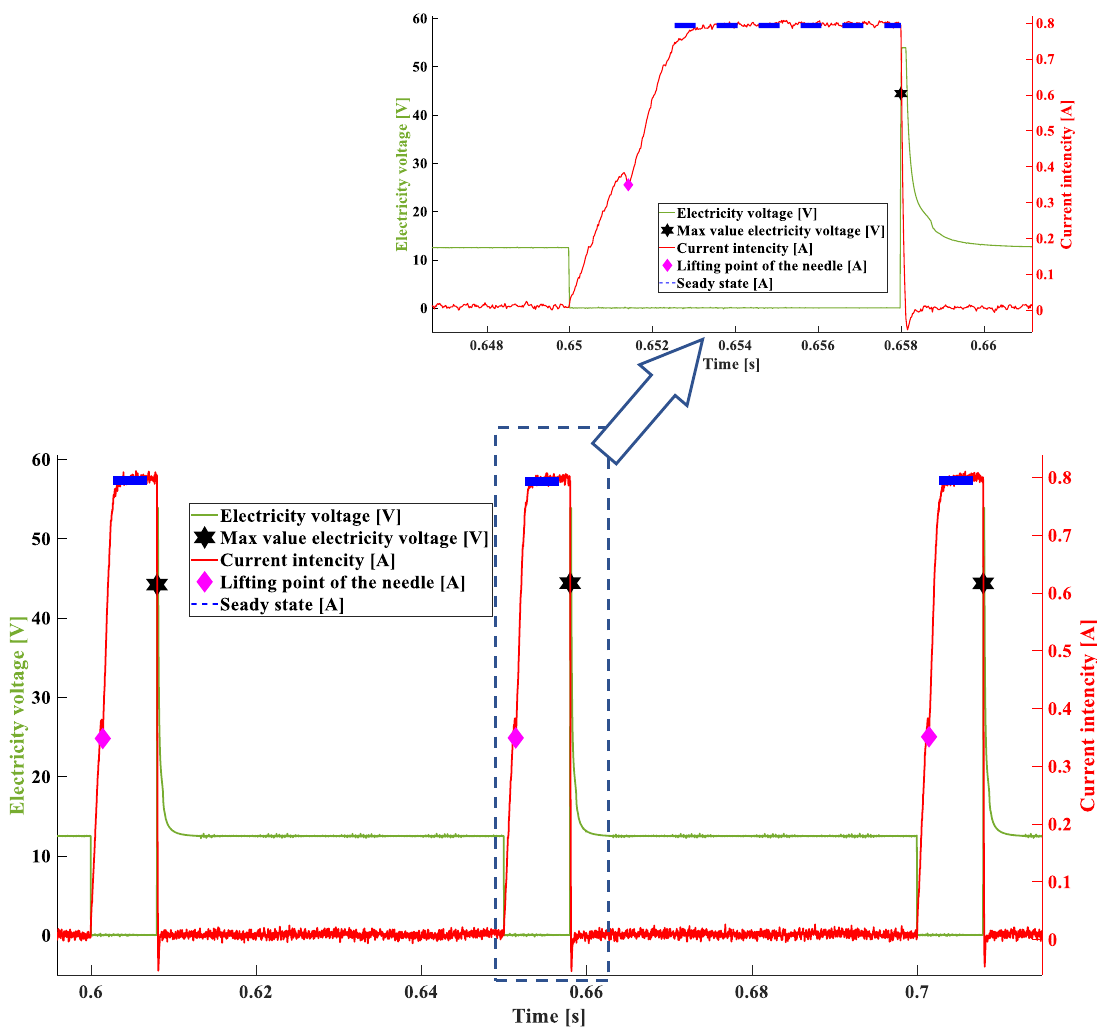
Figure 11. Characteristic values obtained in successive voltage–current waveforms representing the dosage of the fuel injector—exp. III—8 ms, 0.2 MPa.